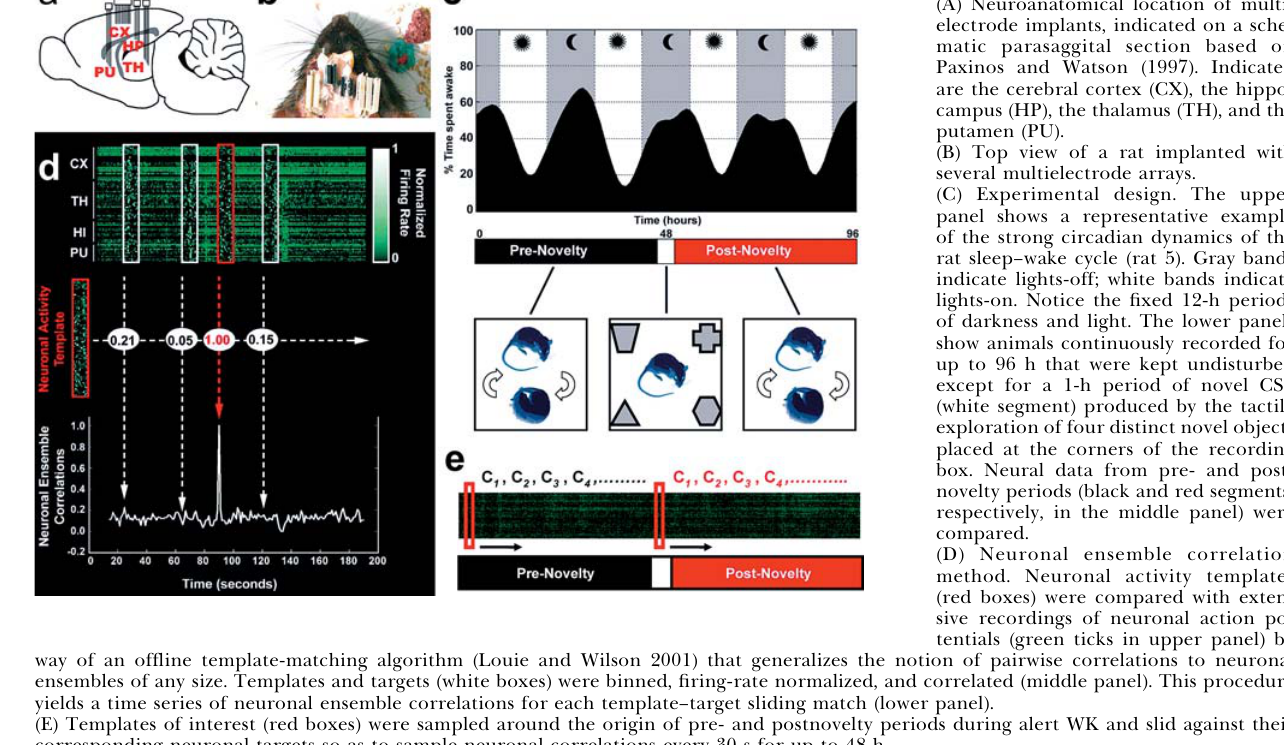
Figure 1. Methodology (A) Neuroanatomical location of multi- electrode implants, indicated on a sche- matic parasaggital section based on Paxinos and Watson (1997). Indicated are the cerebral cortex (CX), the hippo- campus (HP), the thalamus (TH), and the putamen (PU). (B) Top view of a rat implanted with several multielectrode arrays. (C) Experimental design. The upper panel shows a representative example of the strong circadian dynamics of the rat sleep–wake cycle (rat 5). Gray bands indicate lights-off; white bands indicate lights-on. Notice the fixed 12-h periods of darkness and light. The lower panels show animals continuously recorded for up to 96 h that were kept undisturbed except for a 1-h period of novel CSS (white segment) produced by the tactile exploration of four distinct novel objects placed at the corners of the recording box. Neural data from pre- and post- novelty periods (black and red segments, respectively, in the middle panel) were compared. (D) Neuronal ensemble correlation method. Neuronal activity templates (red boxes) were compared with exten- sive recordings of neuronal action po- tentials (green ticks in upper panel) by